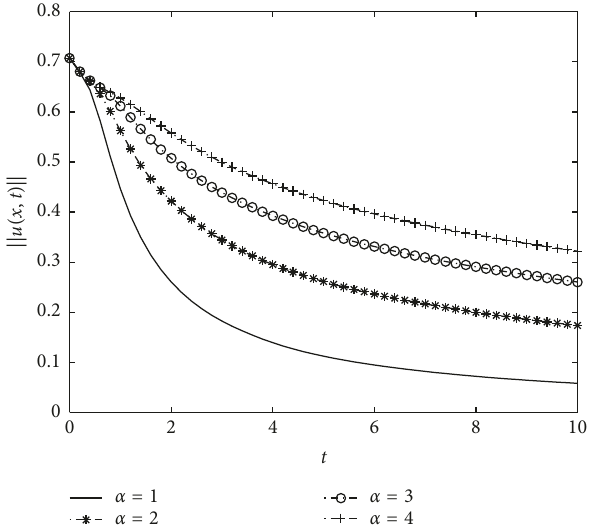
Figure 10: The L 2 -norm of u ( x,t ) , ‖ u ( x,t )‖ , over time for various values of α when applying the third nonlinear adaptive controller � 0 . 0005, r � 0 . 2, r � 0 . 2, and u ( x ) � sin ( π x ) μ � 0 . 001, c 2 1 2 0